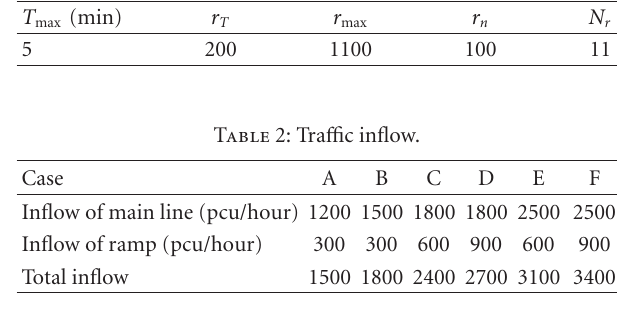
Table 1: RLRM parameters.